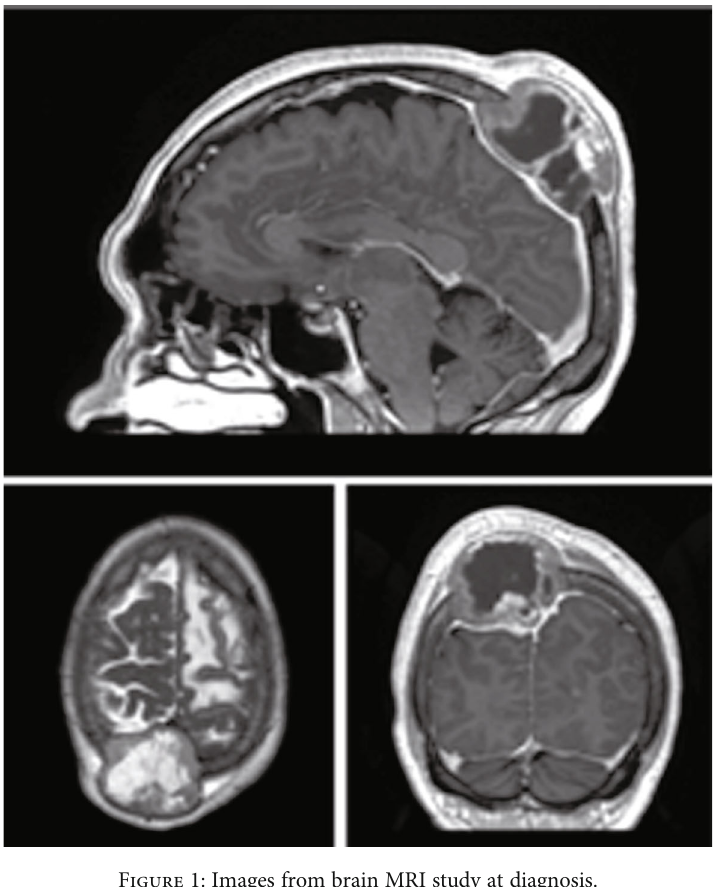
Figure 1: Images from brain MRI study at diagnosis.